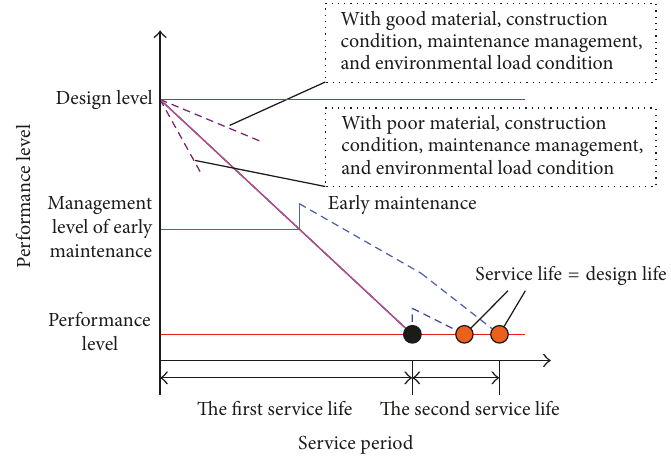
Figure 1: Structure deterioration